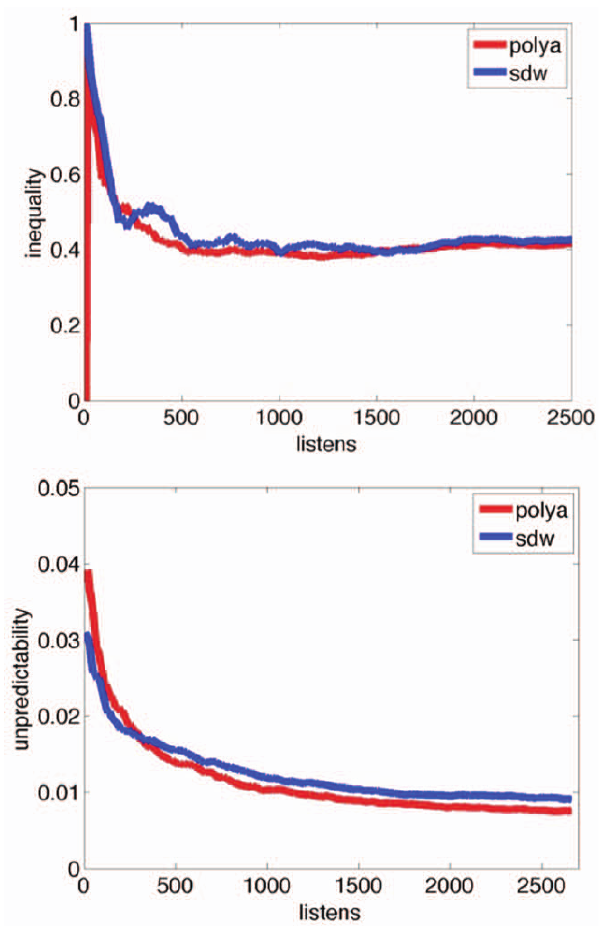
Figure 5. Inequality (top) and unpredictability (bottom) over the course of the market, with alpha=200. Inequality is shown for Experiment 2, world 5. RMSE of simulated market’s unpredictability is=0.0012, and average of inequality